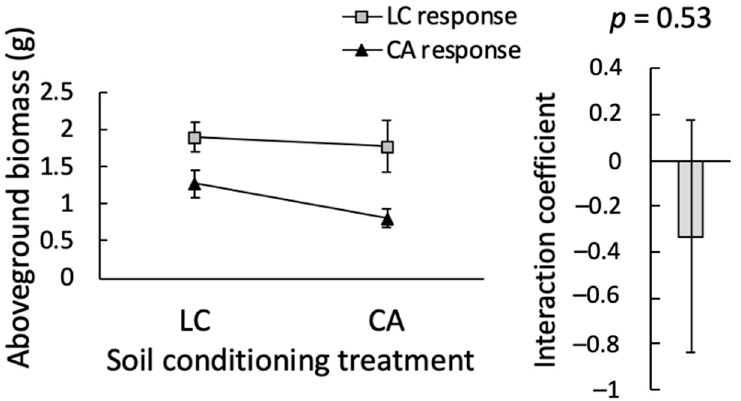
Figure 2. Feedback between Lotus corniculatus (LC) and Cirsium arvense (CA). These species experience neutral feedback. Neither species is significantly affected by soil conditioning treatment, although C. arvense does grow slightly better in soil conditioned by L. corniculatus . The inset shows the interaction coefficient between these species, which does not differ significantly from zero ( p = 0.53), also indicative of neutral feedback. Bars indicate ± SE.